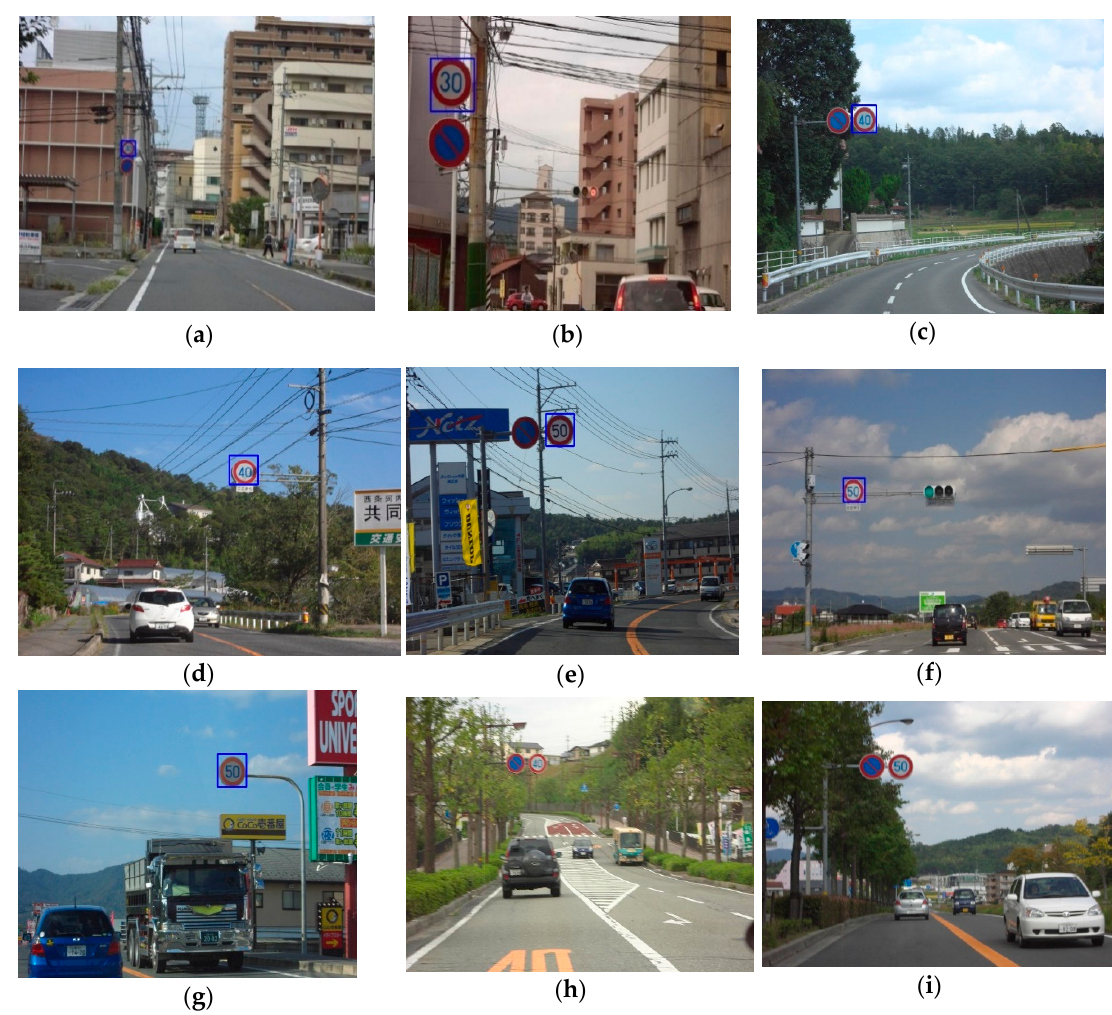
Figure 9. Examples of detected and undetected speed-limit signs. Images ( a – g ) show cases when the speed-limit sign was detected. Images ( h ) and ( i ) show cases when the speed-limit sign was not detected.